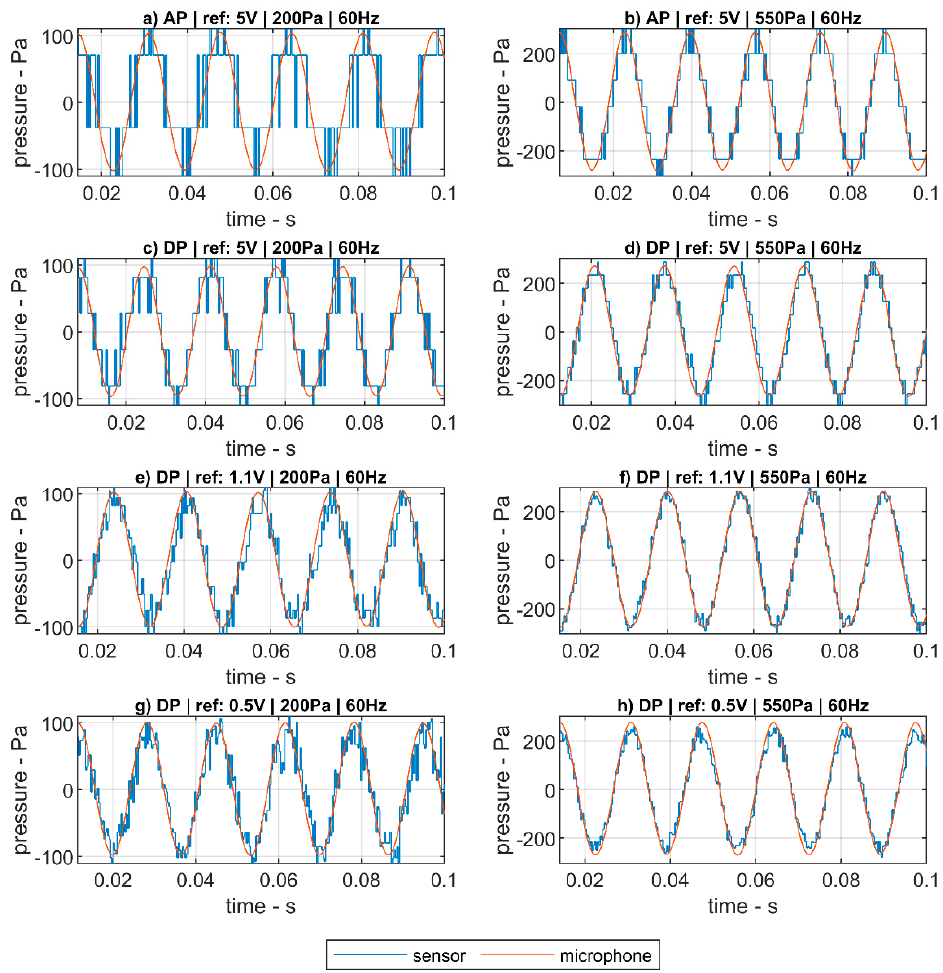
Figure 9. Detail of the improvement in sampling accuracy due to the different sensors’ arrangements: Absolute pressure sensor in ( a , b ); Differential pressure sensor with voltage reference of 5 V in ( c , d ); Differential pressure sensor with voltage reference of 1.1 V in ( e , f ); Differential pressure sensor with voltage reference of 0.5 V in ( g , h ). Column on the left represents the results for low pressure amplitudes: ( a , c , e , g ). Column on the right represents the results for high pressure amplitudes: ( b , d , f , h ).